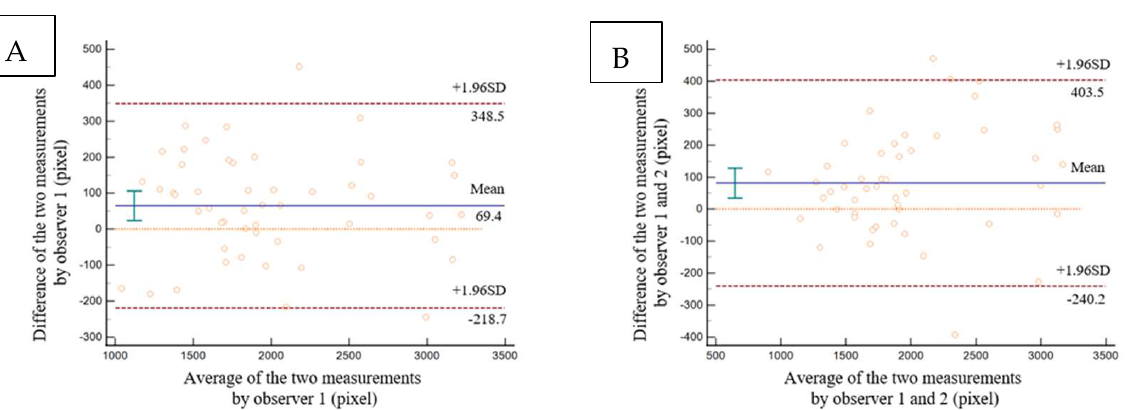
Figure 4. Results of intra-observer and inter-observer agreement for RNFL measurement. ( A ) Results of intra-observer agreement for RNFL measurement. The abscissa was the average of the two measurements from observer 1, and the ordinate was the difference of the two measurements from the same observer. ( B ) Results of inter-observer agreement for RNFL measurement. The abscissa was the average of the two measurements from observer 1 and observer 2, and the ordinate was the difference between the two measurements from observer 1 and observer 2.